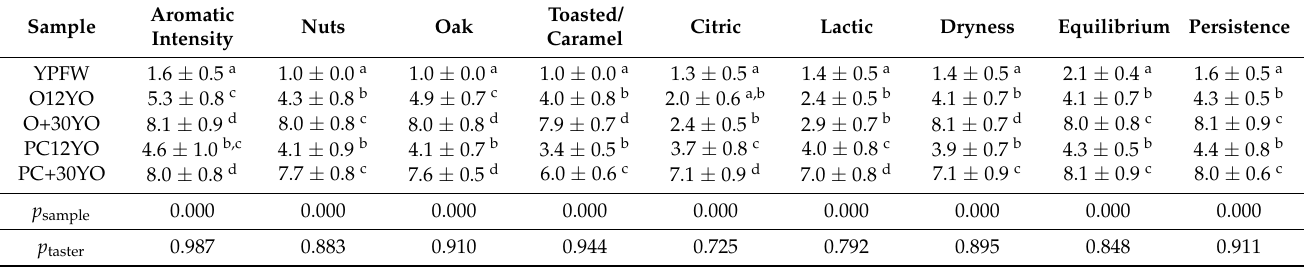
Table 15. Tasting panel scores for the different descriptors of the 5 wines evaluated. Scores are ex- pressed as mean value ± standard deviation of the panel. The p values resulting from the application of two-factor analysis of variance, taking the sample and the taster as the factors of variation, are included. Different superscripts in the scores indicate significant differences among the correspond- ing wines.